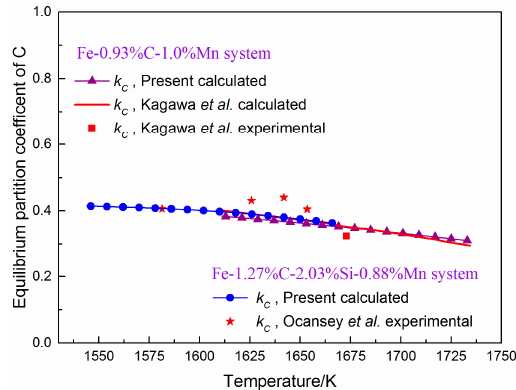
Figure 2. Comparison of k C between the present calculated results and those of the literature (Data of Kagawa et al. from Reference [13]; Data of Ocansey et al. from Reference [12]).